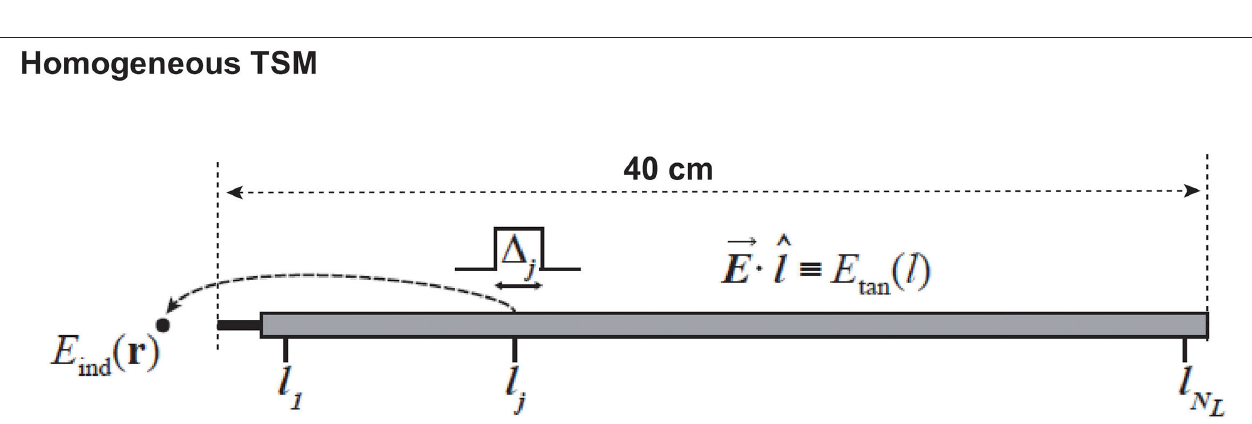
tangential component of the local incident electric field, E tan , is coupled with the implant at length l and the induced electric field around the implanted electrode at r , E ind ( r ) , is evaluated as the transfer function h ( l